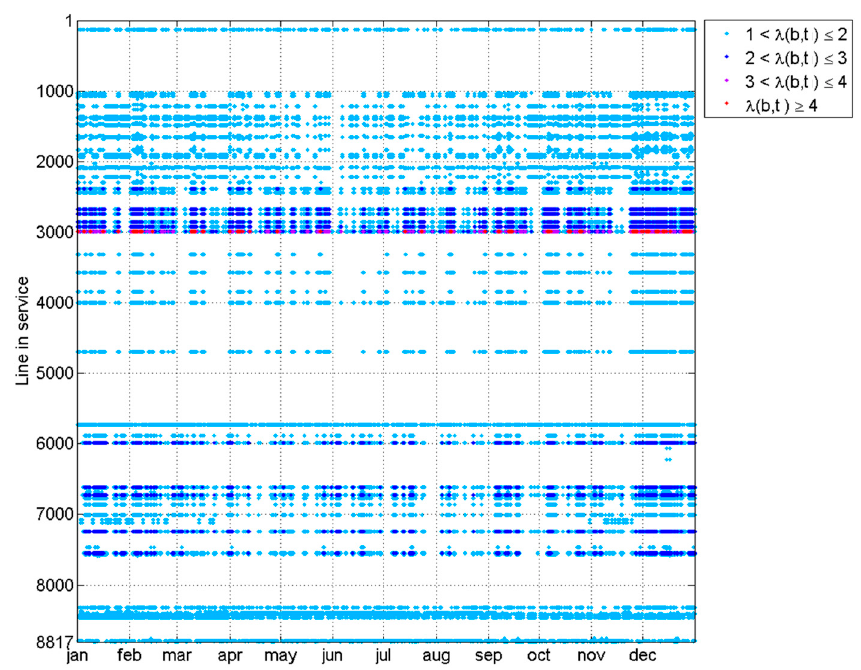
Figure 3. Line loading in the N condition for the yearly operation. Table 2. Characterization of yearly network performances in the N condition.